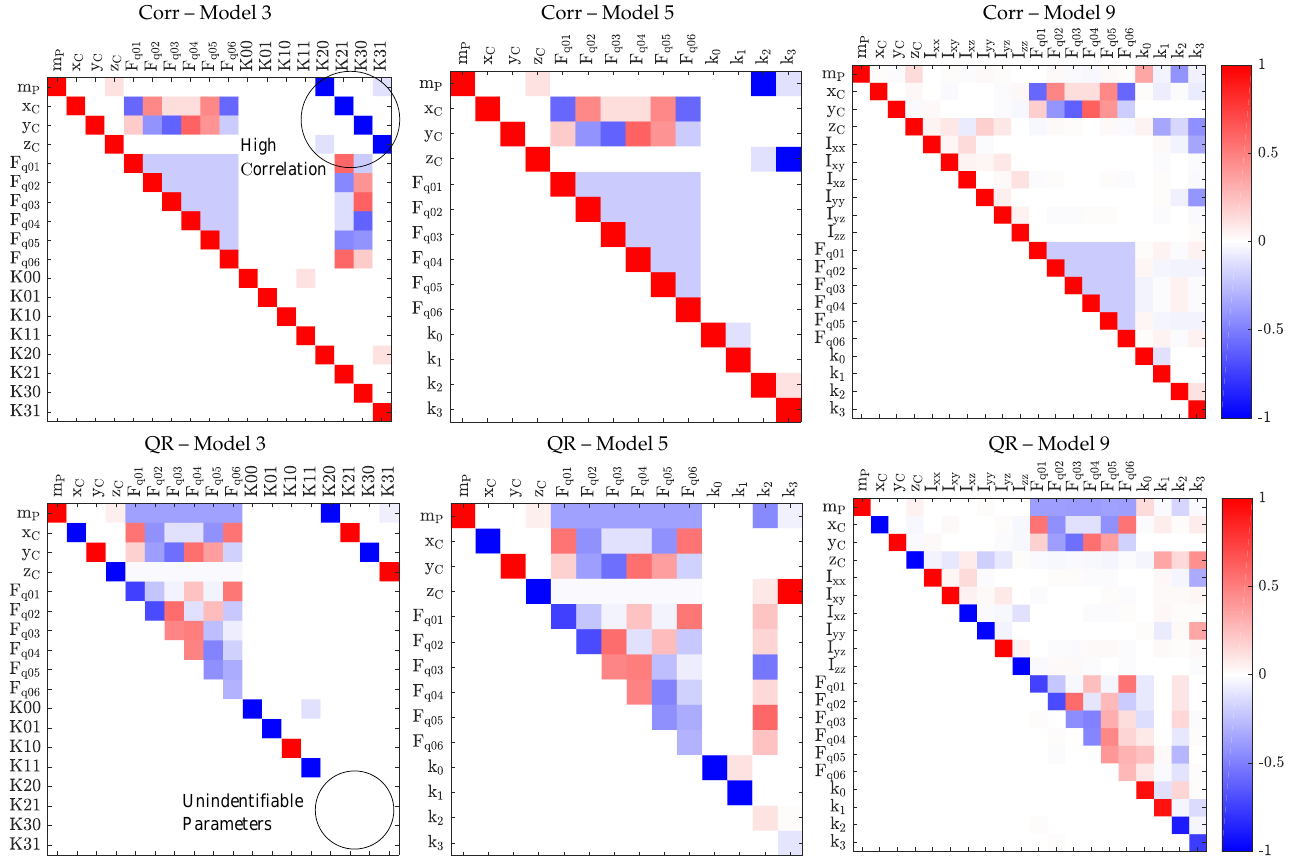
Figure 3. Matrix of Pearson correlation coefficients (Corr) and upper R -part of QR decomposition of ˜ A (QR); left : model 3 (not identifable in any description based on R T g ), centre : preferred quasi-static model 5 (includes models 0, 2), right : preferred dynamic model 9 (includes models 6, 7). The models 1, 4, 8 are not displayed due to too many parameters. Corr shows the pairwise linear correlation between 2 parameters, that points out linear dependencies. In R high values in the row behind the diagonal element indicate dependent parameters. The diagonal elements R ii of R that are less than the numerical zero ( m · n · (cid:101) · max | R ii | ) indicate unidentifiable parameters u i